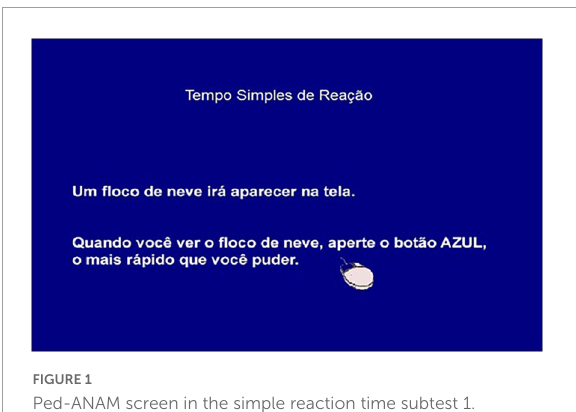
FIGURE1 Ped-ANAM screen in the simple reaction time subtest 1.